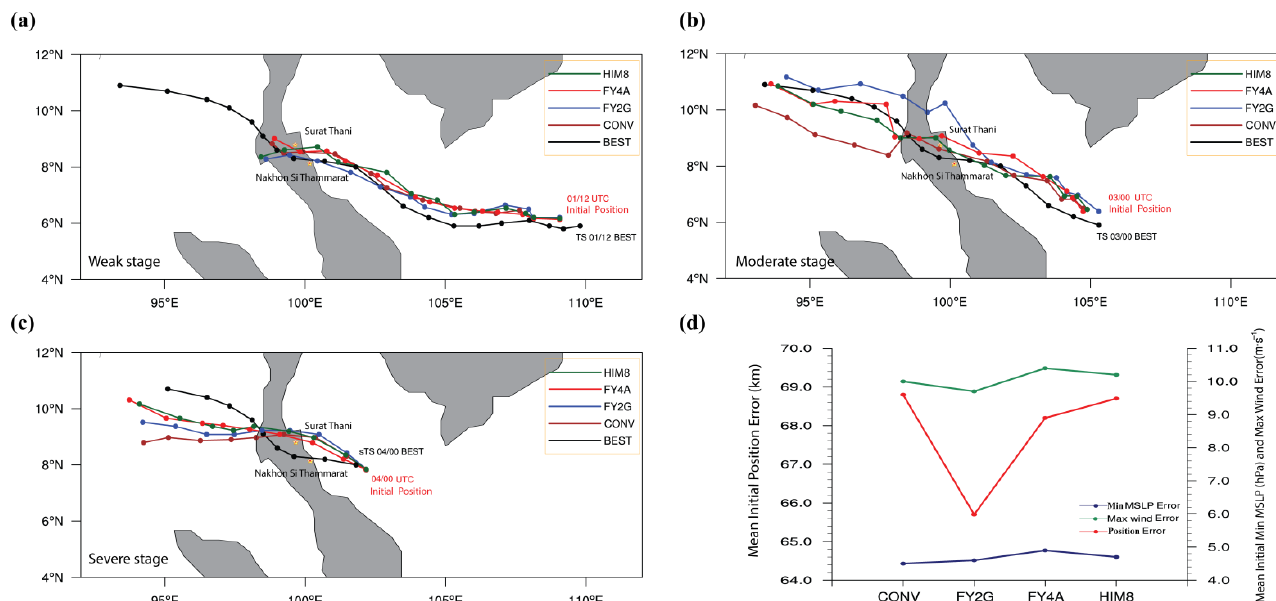
Figure 14. The experiment simulation from the WRF model of CONV (brown), FY2G (blue), FY4A (red), and HIM8 (green) in the initial position and forecast tracks for TC PABUK from ( a ) 12:00 UTC 1 January 2019, ( b ) 00:00 UTC 3 January 2019, and ( c ) 00:00UTC 4 January 2019, respectively, and ( d ) average of initial position (red), maximum surface wind (green) and minimum MSLP error (blue) of 4 experiments — these were computed based on six different initial conditions.